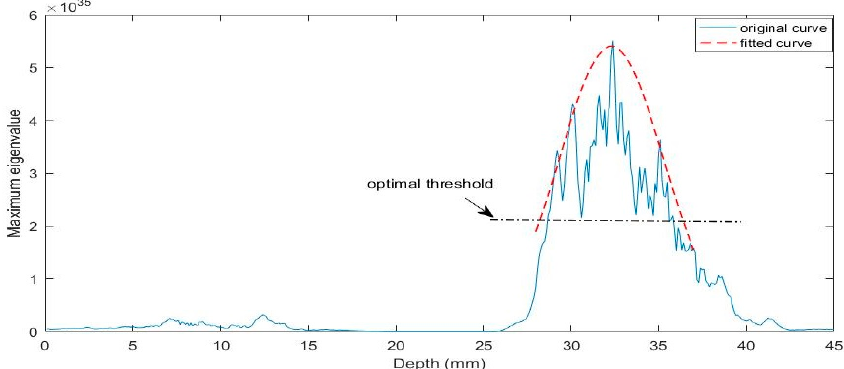
Figure 5. The fitted eigenvalue curve.